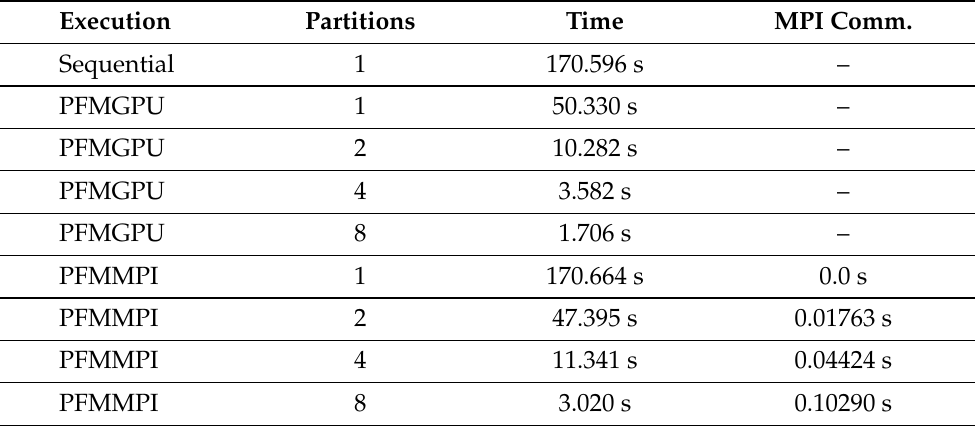
Table 2. Runtimes for the ellipsis